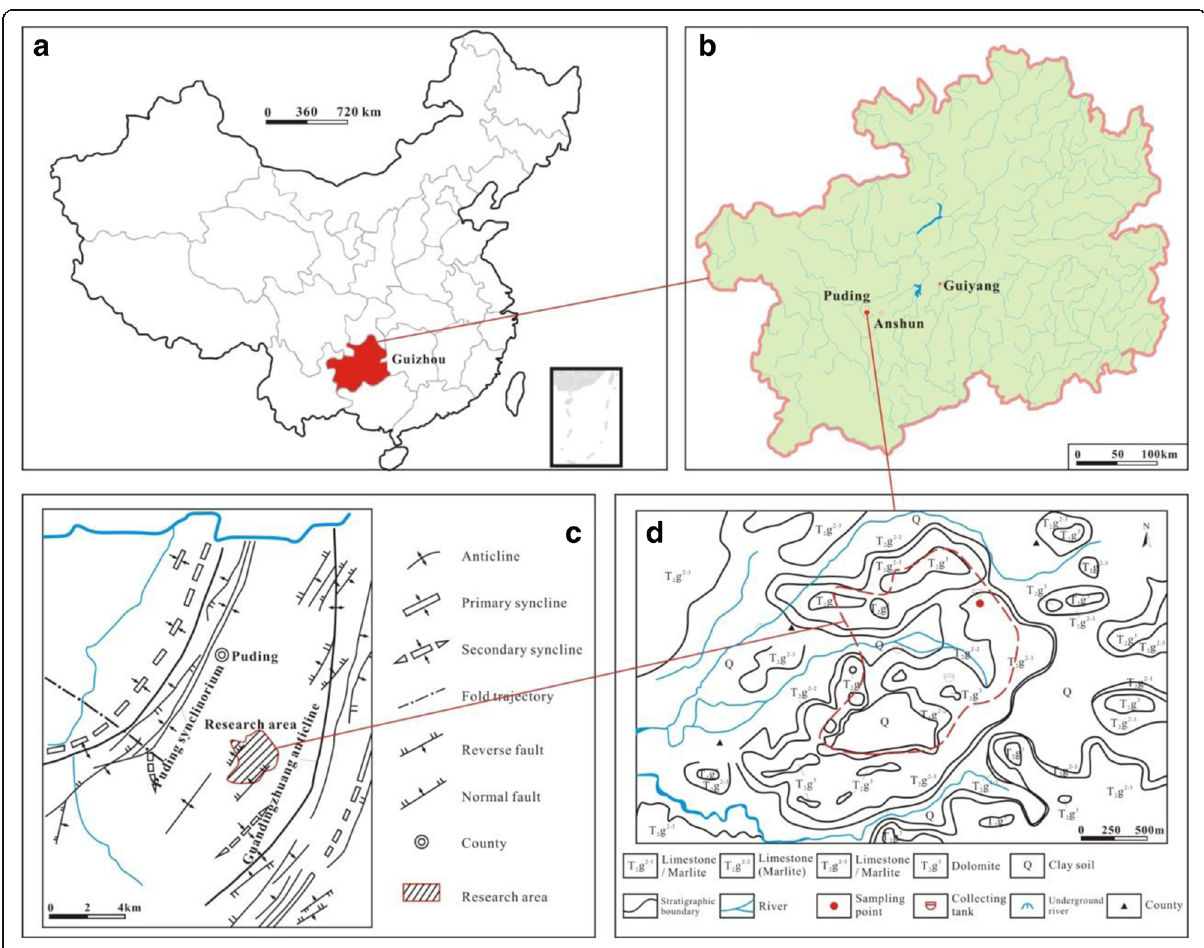
Fig. 2 Location of study area: ( a ) Location of Guizhou province in China; ( b ) Location of research area; ( c ) Geological structure of research area; ( d ) Karst geological map of research